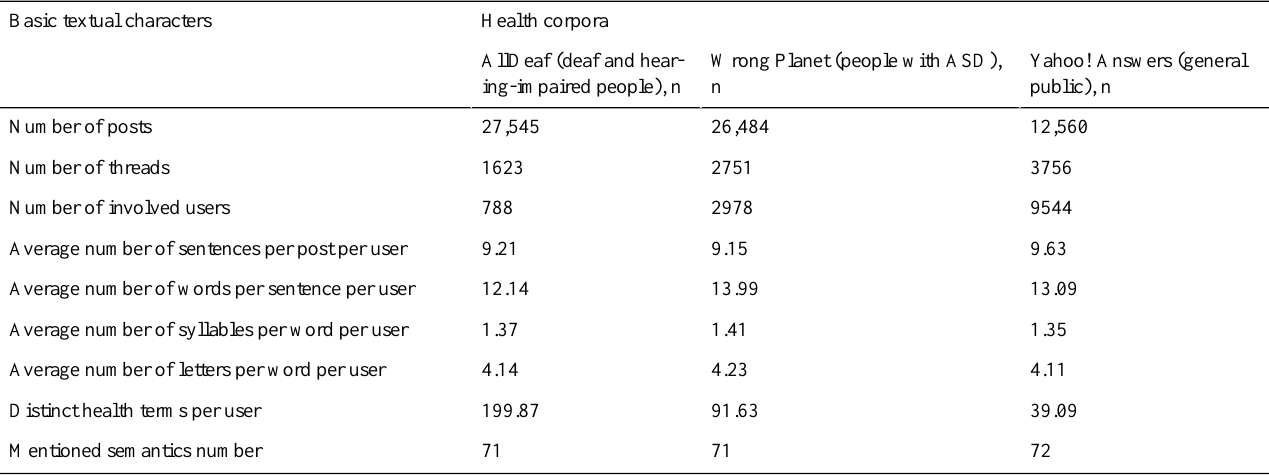
Table 2. Basic textual characteristics of the 3 health